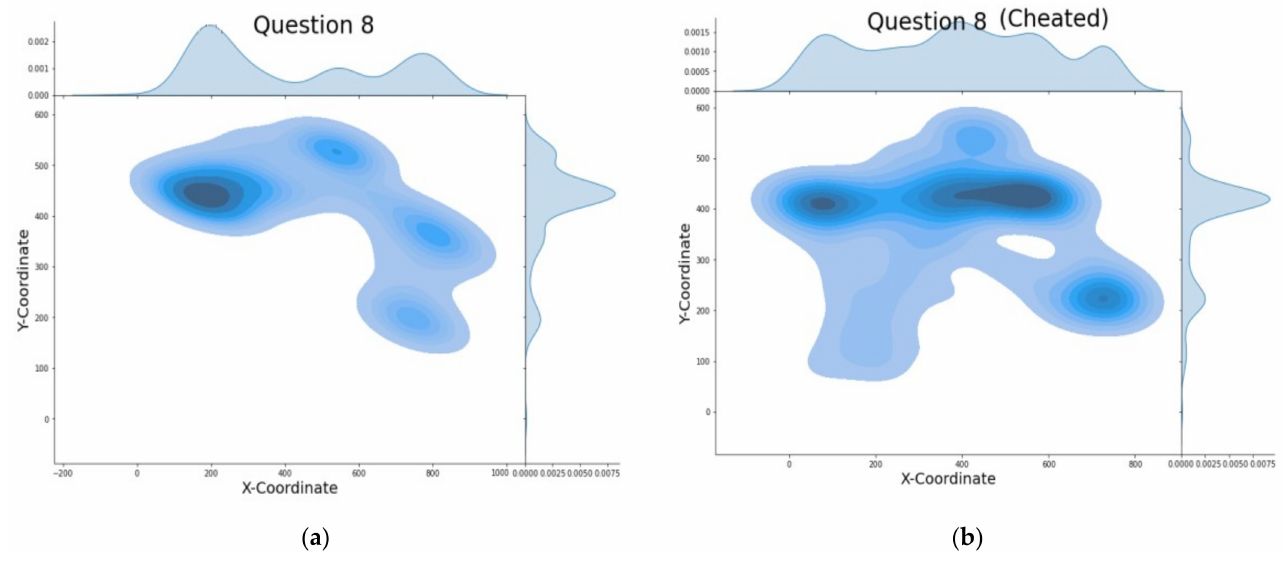
Figure 11. 2-d KDE plot showing the density distribution of raw mouse cursor movements of students as follows: ( a ) a KDE plot of question 8 answered by students without cheating; ( b ) a KDE plot of question 8 answered by students who are allowed to cheat.